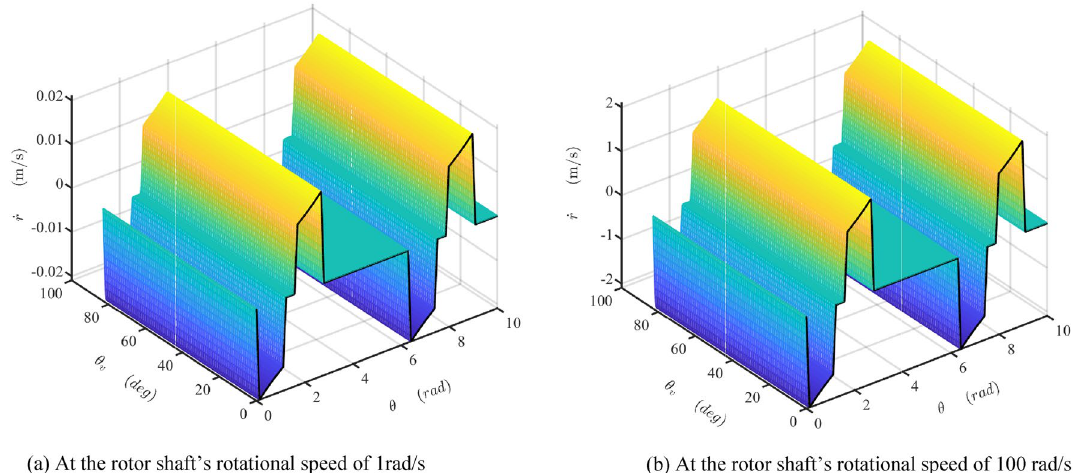
Figure 10. Radial speed map of the vane at two different the rotor shaft’s rotational speed. (Matlab2019a. https:// ww2. mathw orks. cn/ produ cts/ get- matlab. html?s_ tid= gn_ getml).